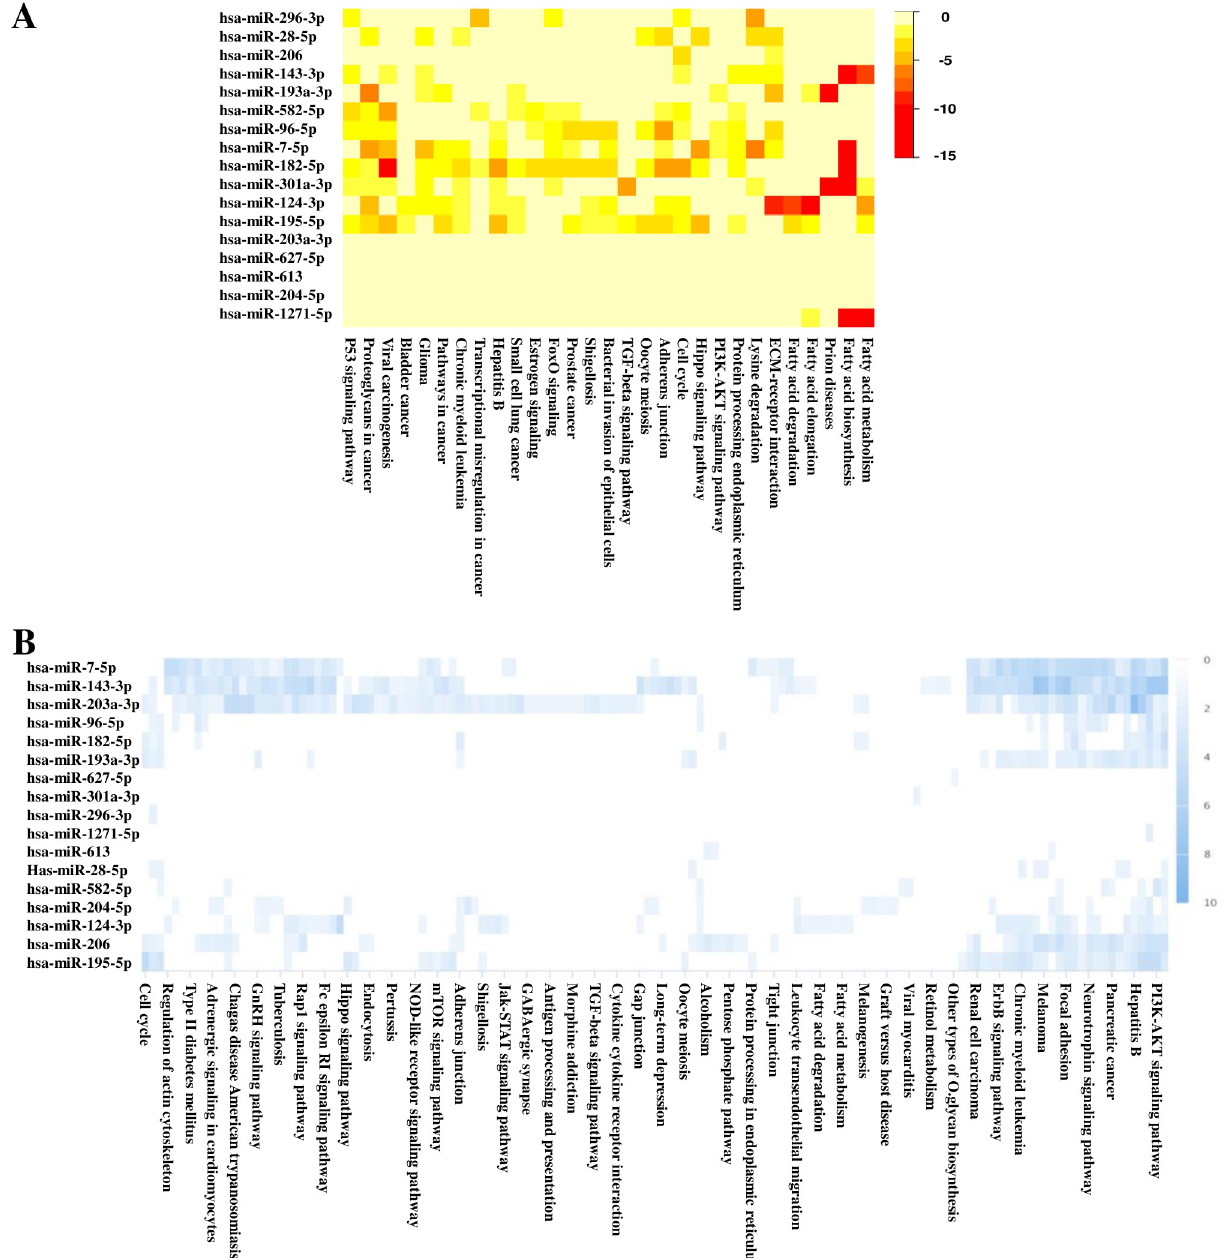
Fig 5. UCA1 functions as a miRNA sponge to remodel the miRNA networks. The miRNA networks associated with UCA1 elevation were predicted by ( A ) DIANA Tools mirPath and ( B ) miRPathDB v2.0. Heat map analyses indicate the statistic significances (-log p-values) of major down-stream pathways regulated by the altered miRNA